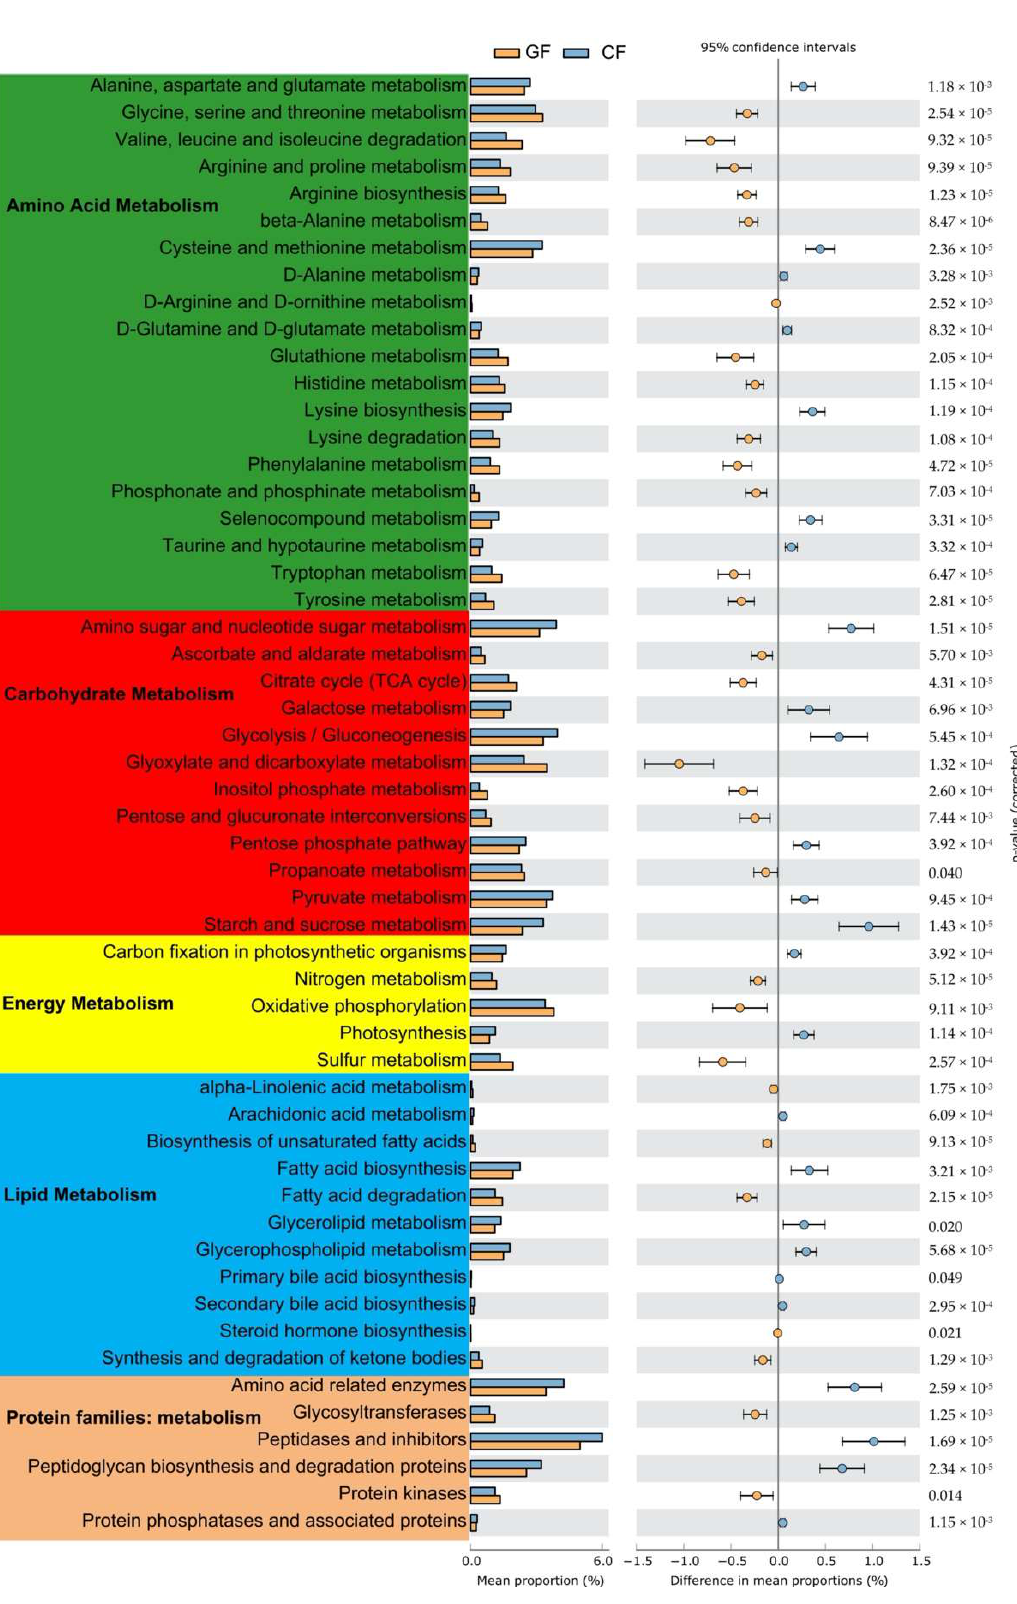
Figure 8. Significant changes in intestinal bacterial Kyoto Encyclopedia of Genes and Genomes (KEGG) pathways between ryegrass diet-fed and commercial diet-fed grass carp using the response ratio method at a 95% confidence interval (CI).